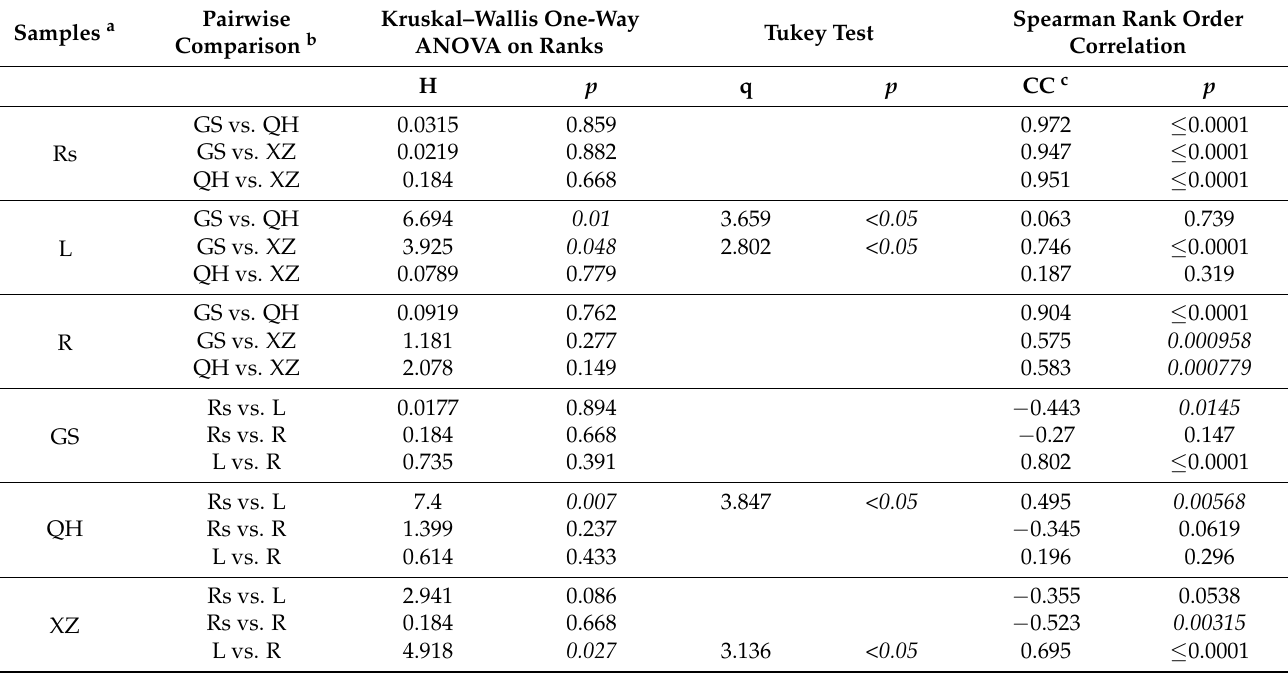
Table 3. Values showing significance of the effects of plant growth elevations and habitats from Kruskal–Wallis one-way ANOVA on ranks (Tukey test) and Spearman rank order correlation for the bacterial communities of S. purpurea